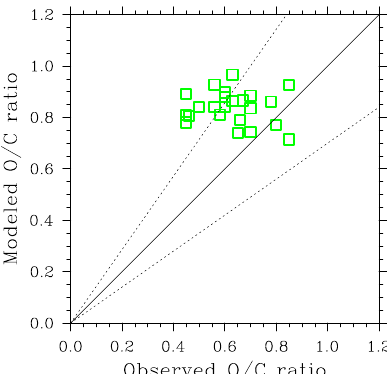
Figure 8. Comparison of O/C ratio estimated by Ng et al. (2010) for urban downwind, rural and remote sites with those simulated in Case 1. The values for other cases are similar to those in Case 1. Solid lines show the 1:1 ratio, and dashed lines show the 10:7 and 7:10 ratios, which roughly corresponds to the uncertainty of the AMS measurements, stated as 30% for the O/C ratio (Aiken et al. 2008). The measurements at the various sites were made in different seasons and different years between 2000 and 2009 and were reported for the average of different durations spanning from 8 to 36 days. The model results are the average values over the same months as the observations.